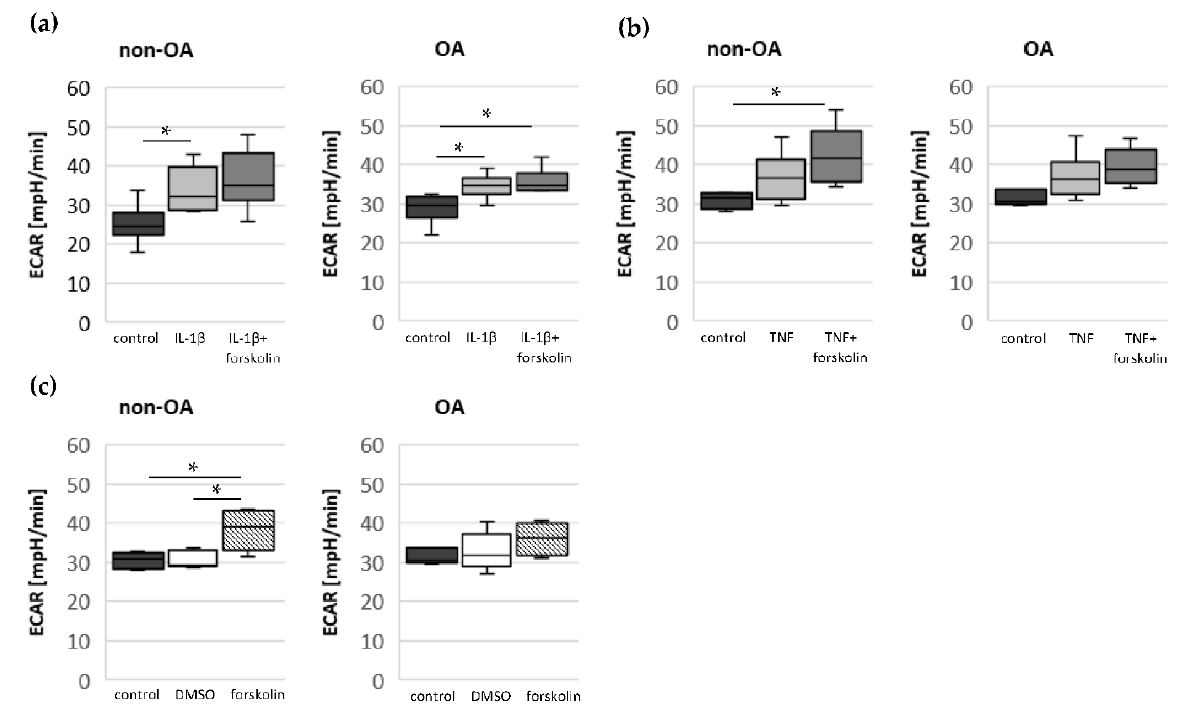
Figure 4. Glycolytic rate measured by ECAR in unstimulated cells (control) and after stimulation with ( a ) IL-1 β and forskolin (non-OA patients = 6, OA patients = 7), ( b ) TNF and forskolin (non-OA patients = 6, OA patients = 6) and ( c ) forskolin and DMSO (non-OA patients = 6, OA patients = 6). Values are displayed as box plots. Statistics: Kruskal–Wallis test followed by Mann–Whitney U test and Bonferroni correction. * p < 0.05. DMSO: dimethyl sulfoxide; ECAR: extracellular acidification rate.